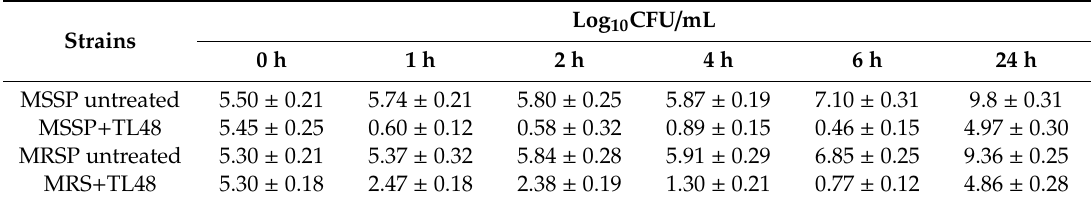
Table 4. Time-kill assay of peptide 8 against methicillin-susceptible S. pseudintermedius (MSSP) and MRSP. Each experiment is the result of three independent experiments performed in triplicate.